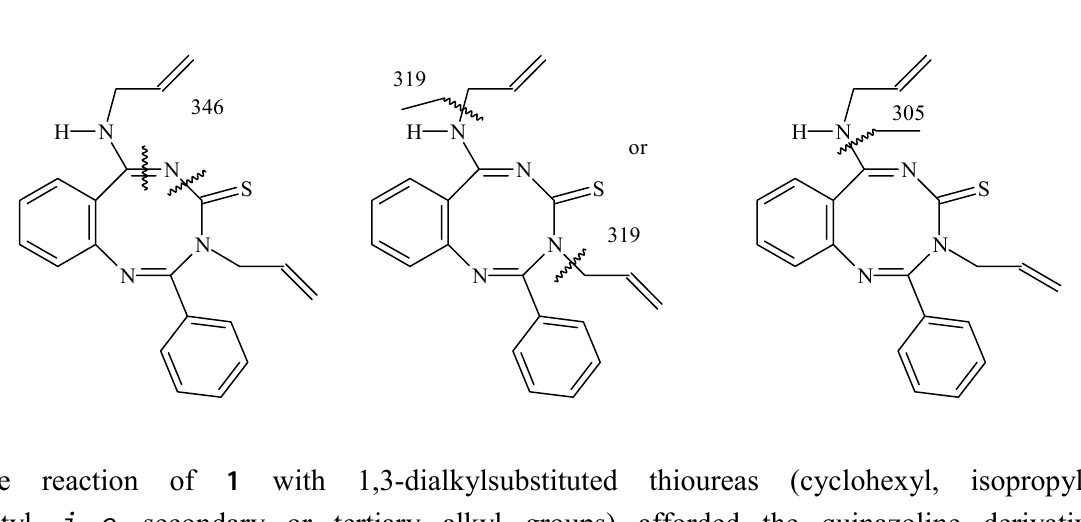
Figure 1. Fragmentations of